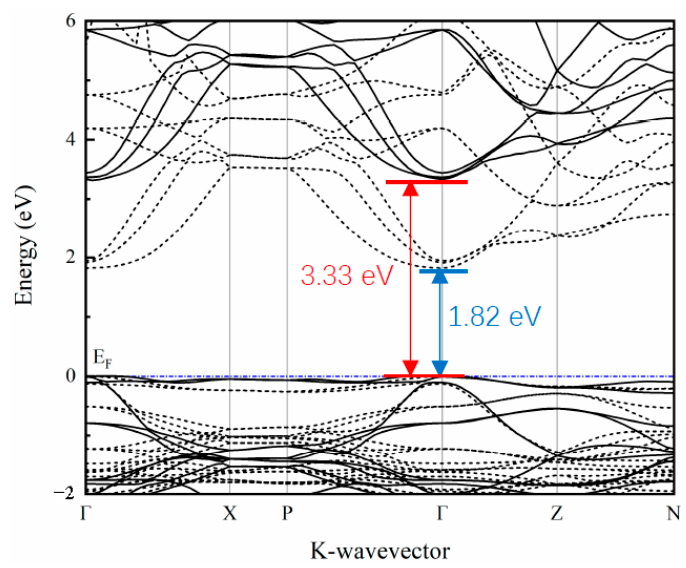
Figure 2. Calculated band structure of SrCu 2 O 2 using the HSE hybrid functional method (solid line). That band structure calculated with traditional the DFT method (dashed line) is also shown for comparison.